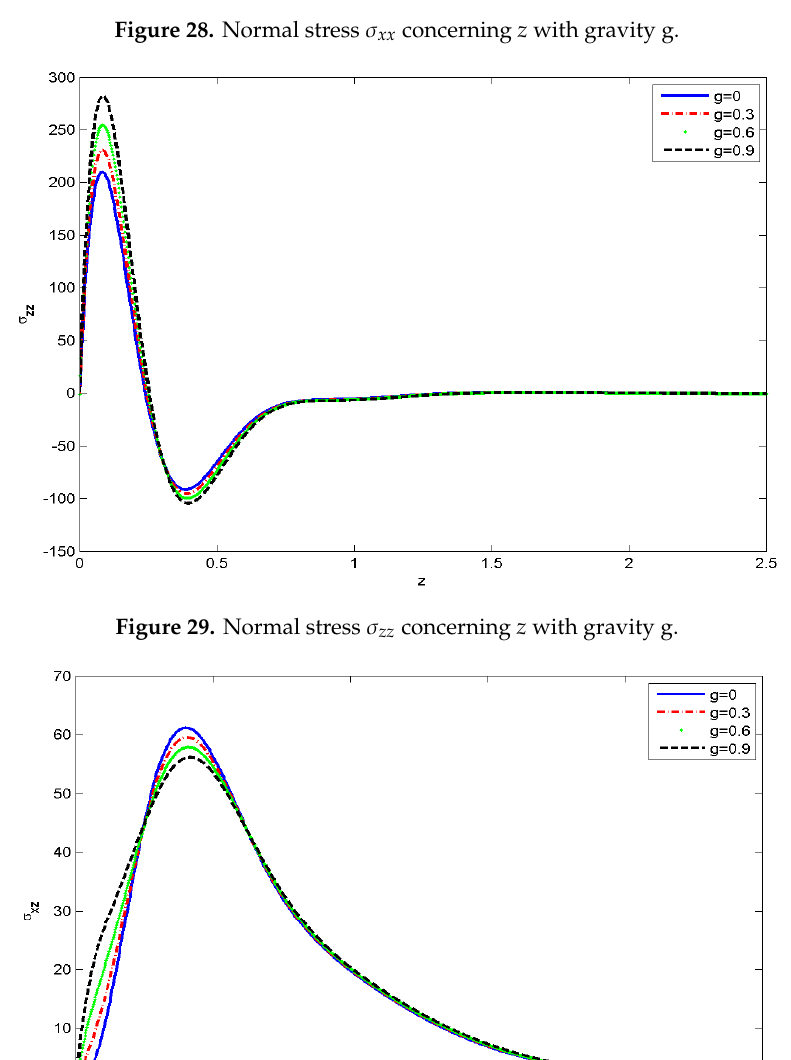
Figure 31. Maxwell stress zz τ concerning z with gravity g.